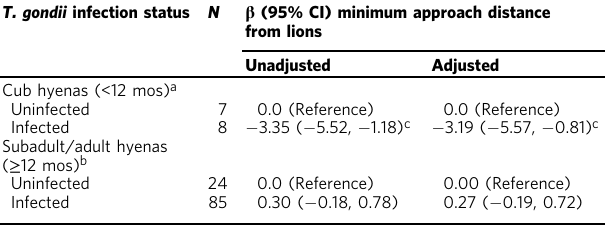
Table 2 Associations of T. gondii infection with minimum approach distance to lion(s) among spotted hyena cubs ( N = 15) and subadults/adults ( N = 109).